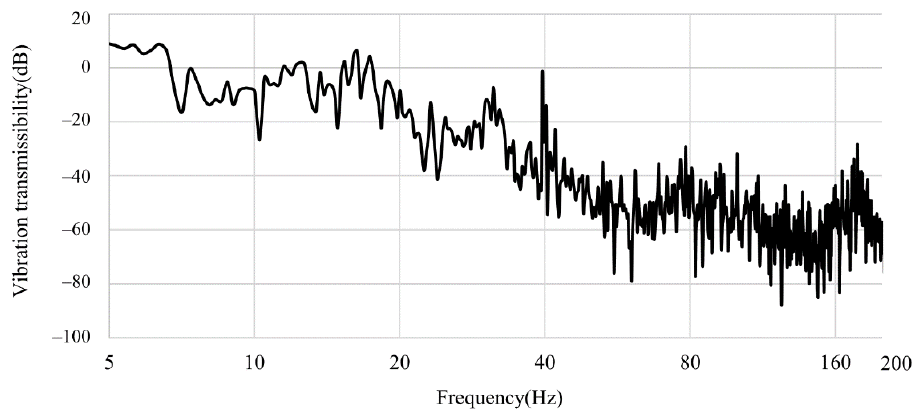
Figure 12. Shell-antenna vibration transmission rate.